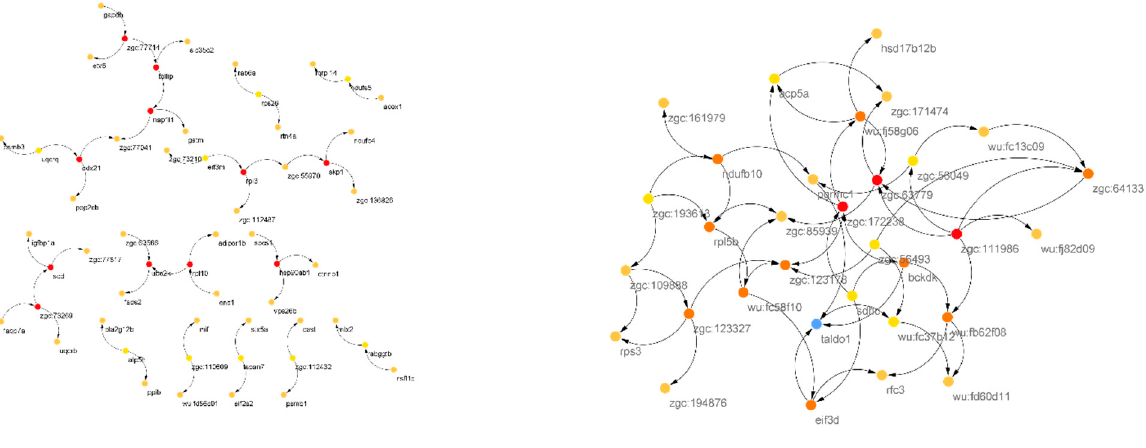
Module 2 Figure 9. Reconstructed Bayesian network for identified modules (Module 1: left; Module 2: right) of co-expression network. Only connected genes are shown. The identified CST genes from the reconstructed BN form modules obtained from